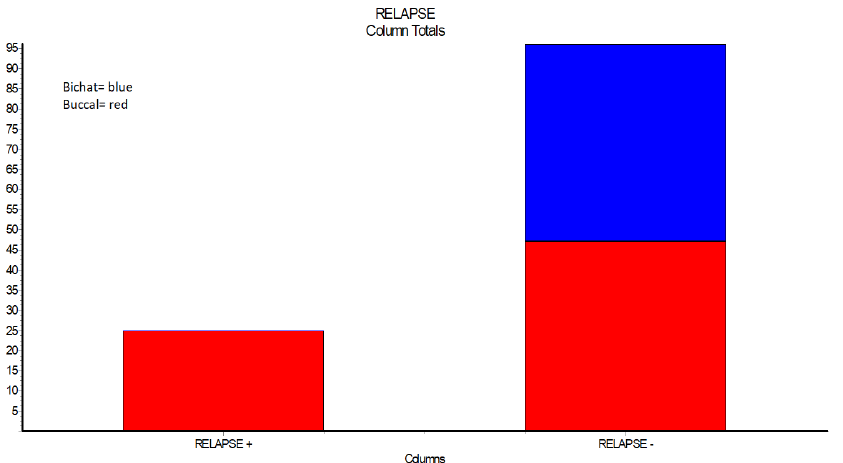
Figure 1. Relapse in case of surgical closure with Bichat fat pad flap and case of closure with Buccal advancement flap.